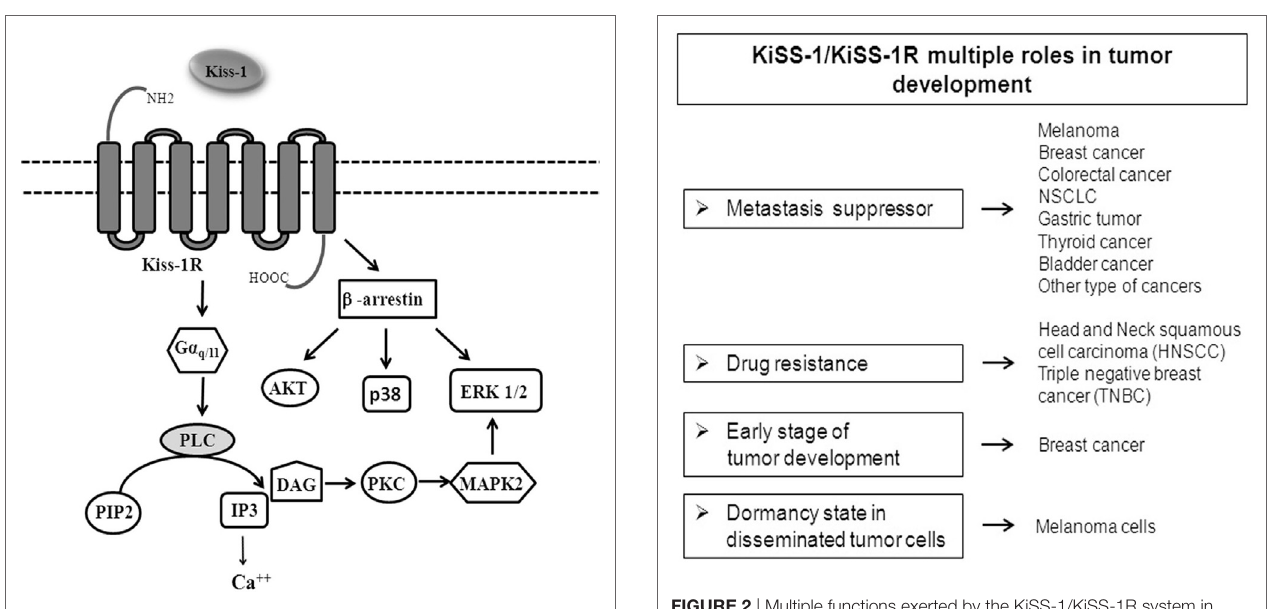
FigURe 2 | Multiple functions exerted by the KiSS-1/KiSS-1R system in regulating tumor progression.